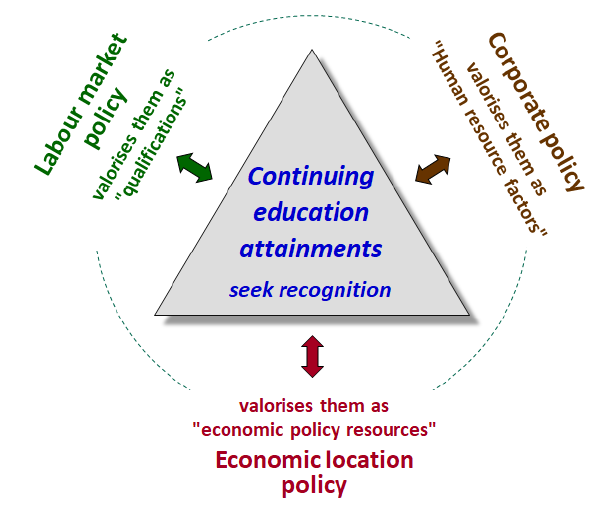
Figure 1. Market players and policies determine the rules for valorising continuing education (author’s own